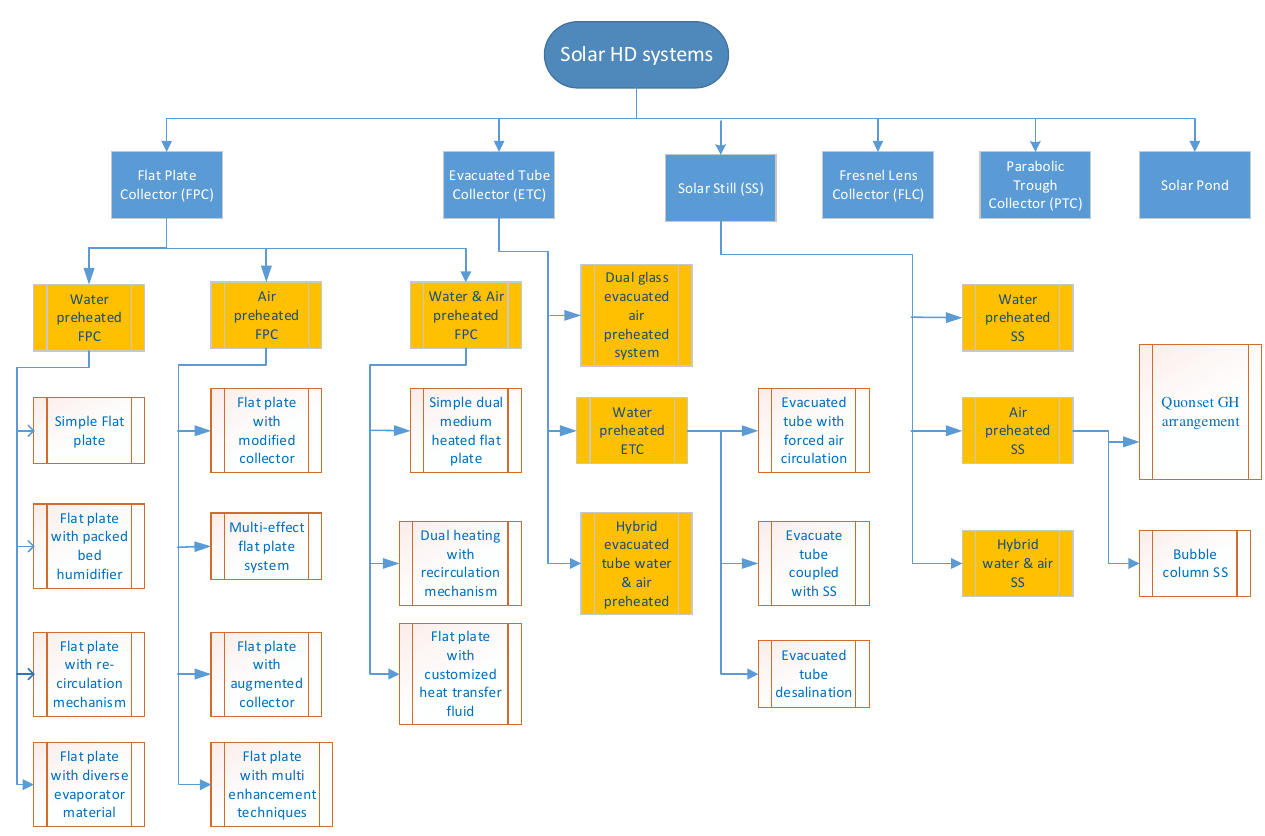
Figure 7. Classification of solar HD systems.